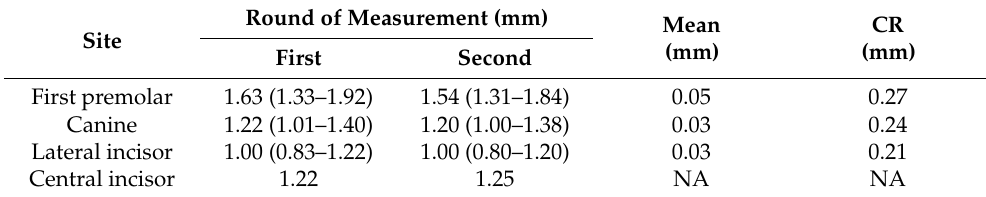
Table 3. Variability in measurement of MIC diameter.